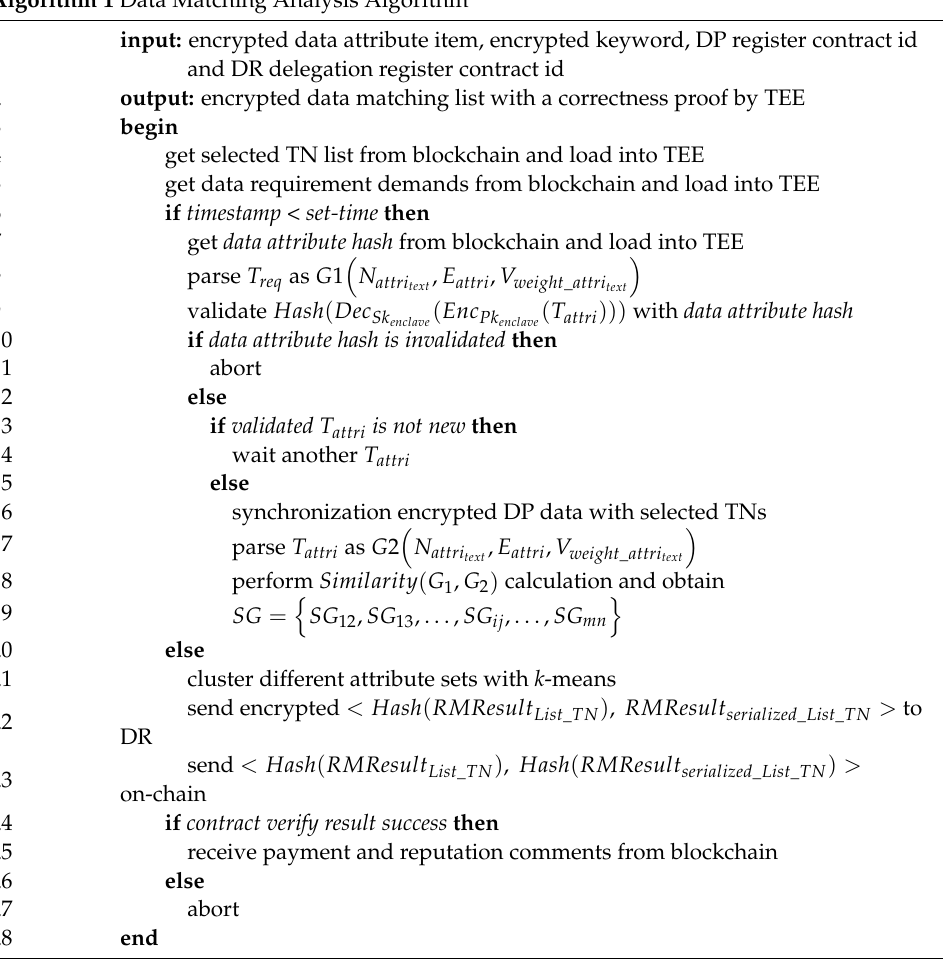
Algorithm 1 Data Matching Analysis